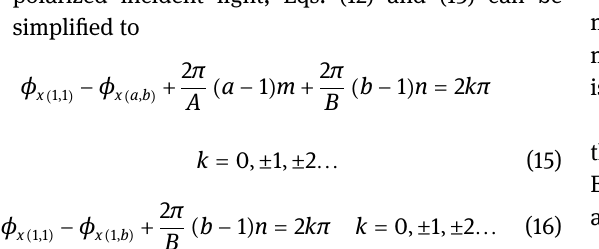
̅ √ 1 [ ] in Eqs. (6) and 2 i 2